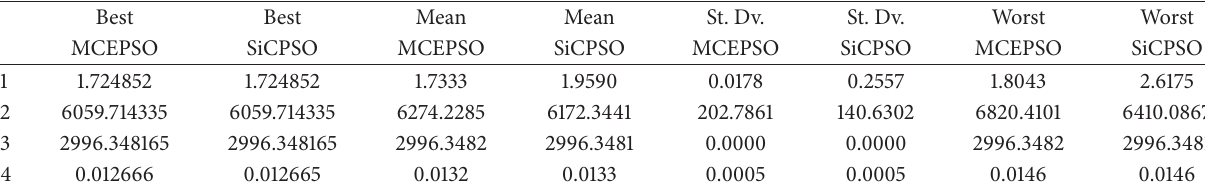
Table 2: FIT: results with 20 particles: 1500 iterations. Statistics over 50